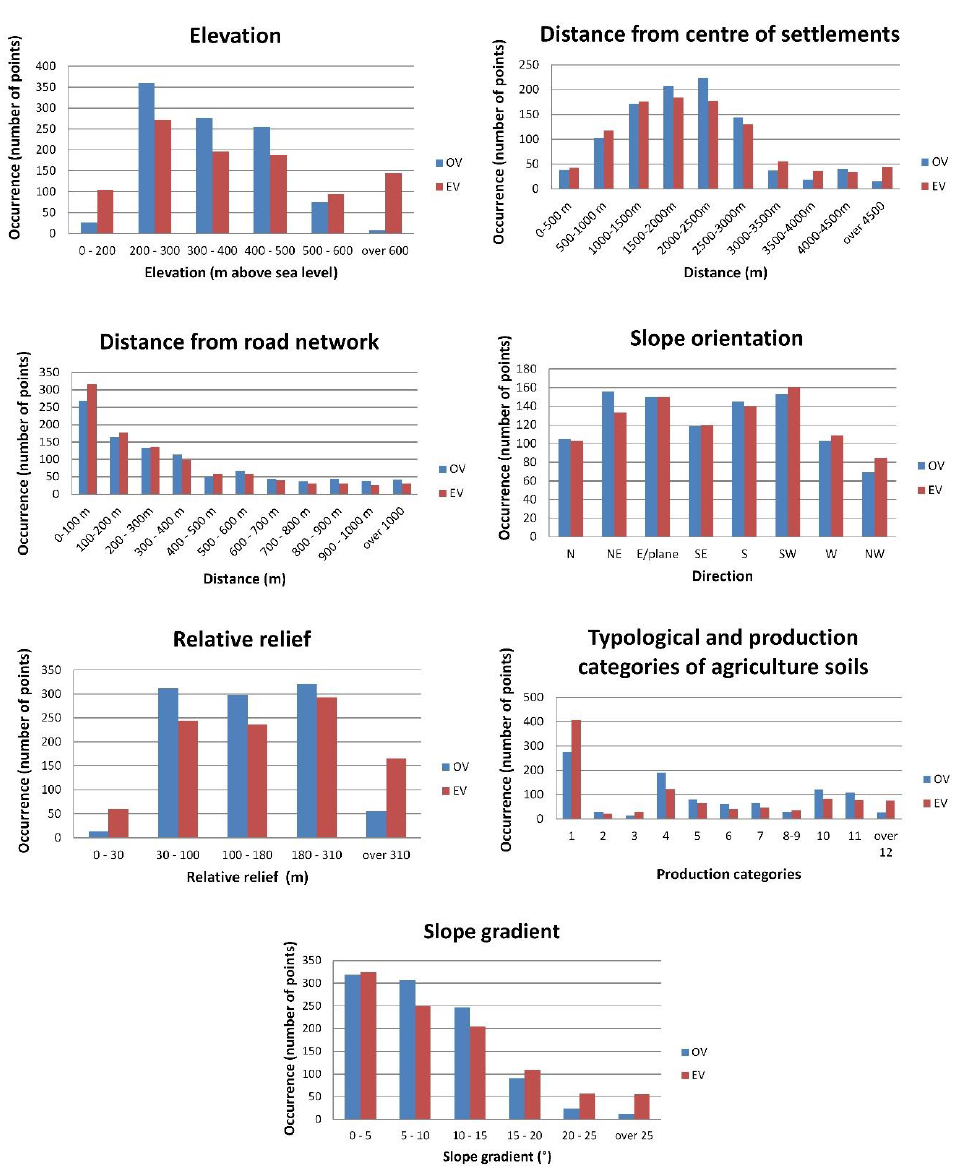
OV—observed values and EV—expected Figure 4. Association of historical wood-pasture presence and evaluated environmental variables; OV — observed values and EV — expected values.